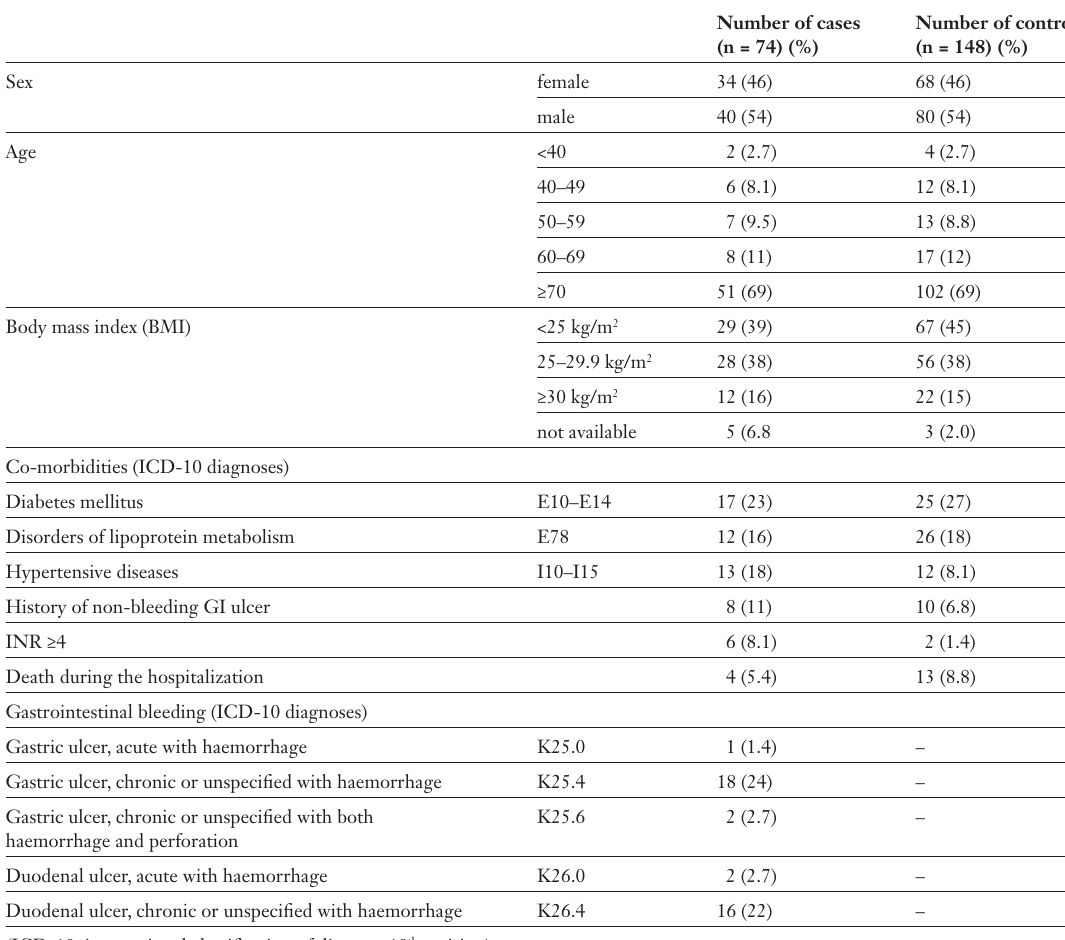
Table 1 Patient characteristics of cases with first- time gastrointestinal bleeding and matched